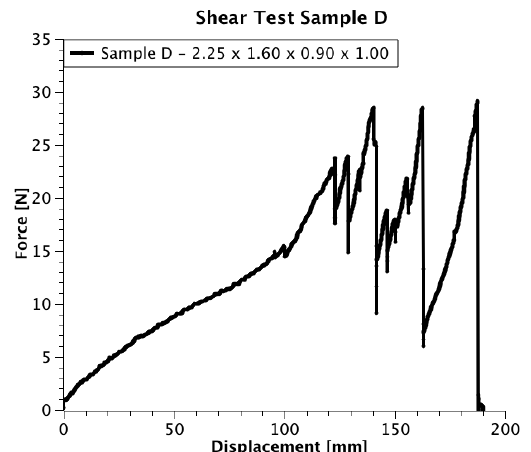
Figure 10. Raw-data of sample D; force F is plotted over displacement x .